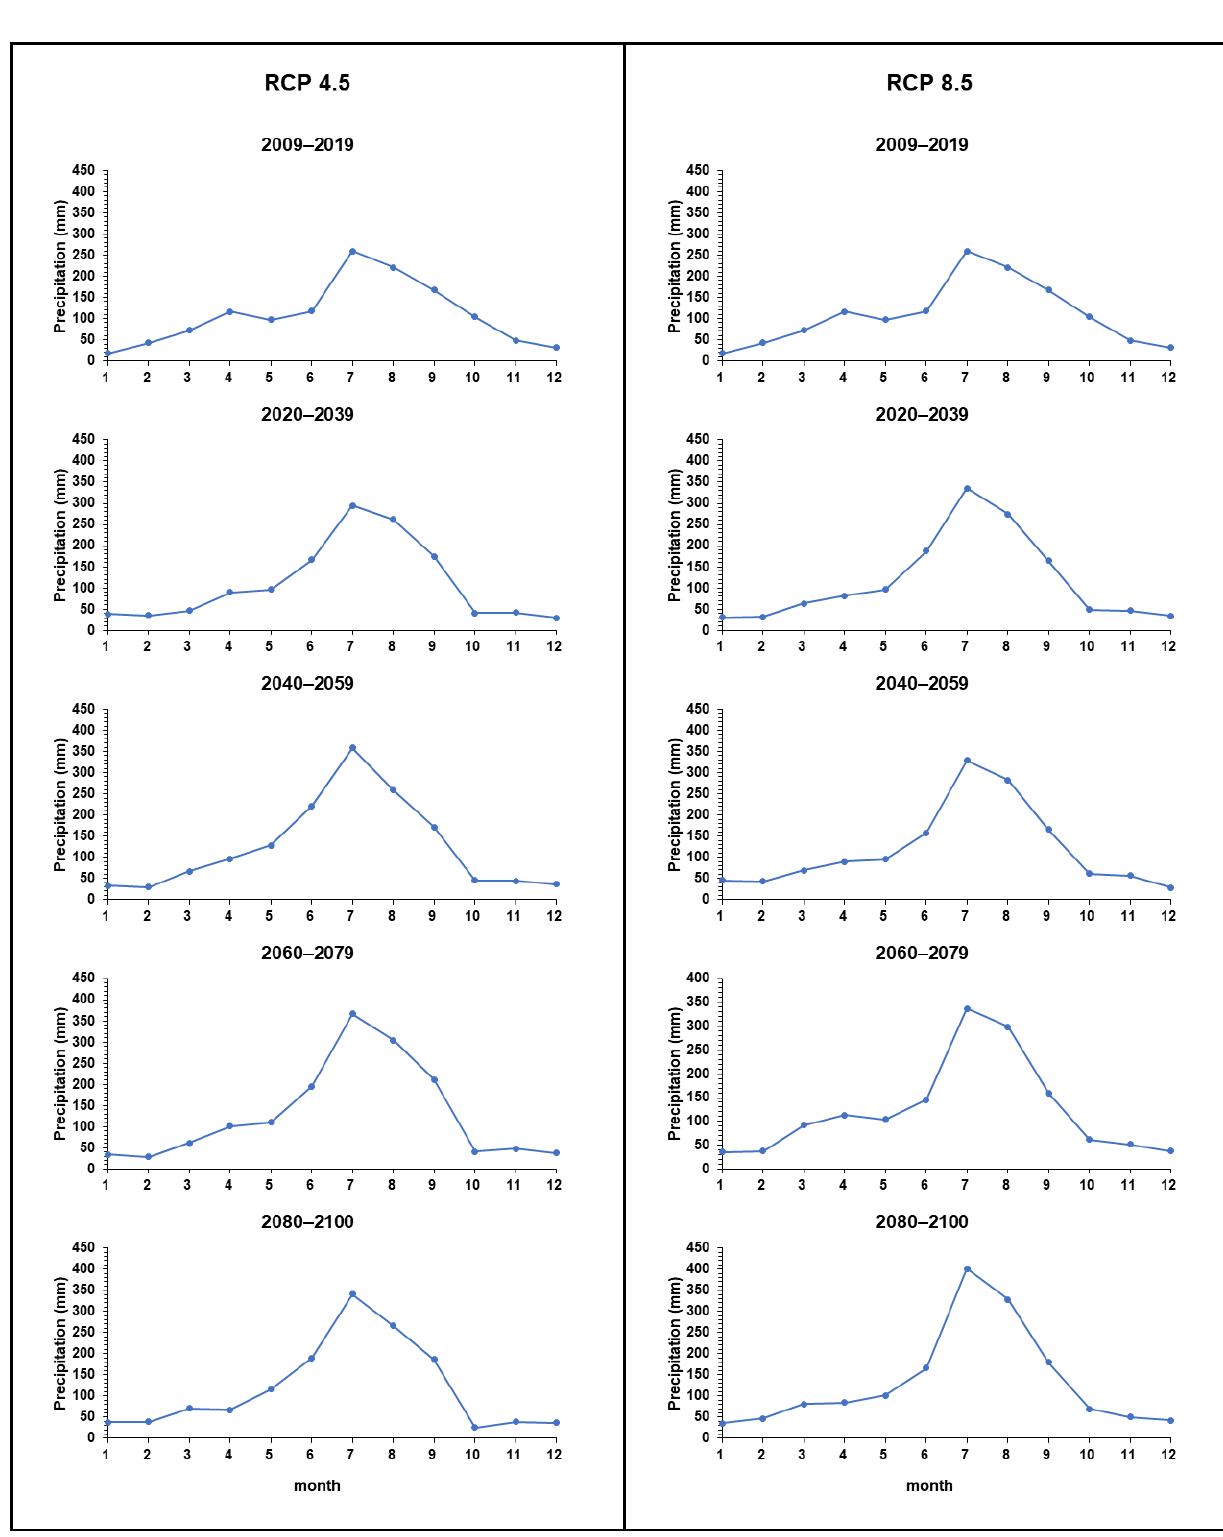
Figure 6. Seasonal trend of precipitation for the periods of 2009 – 2019, 2020 – 2039, 2040 – 2059, 2060 – 2079, and 2080 – 2100 using the RCP 4.5 and 8.5 climate change scenarios.